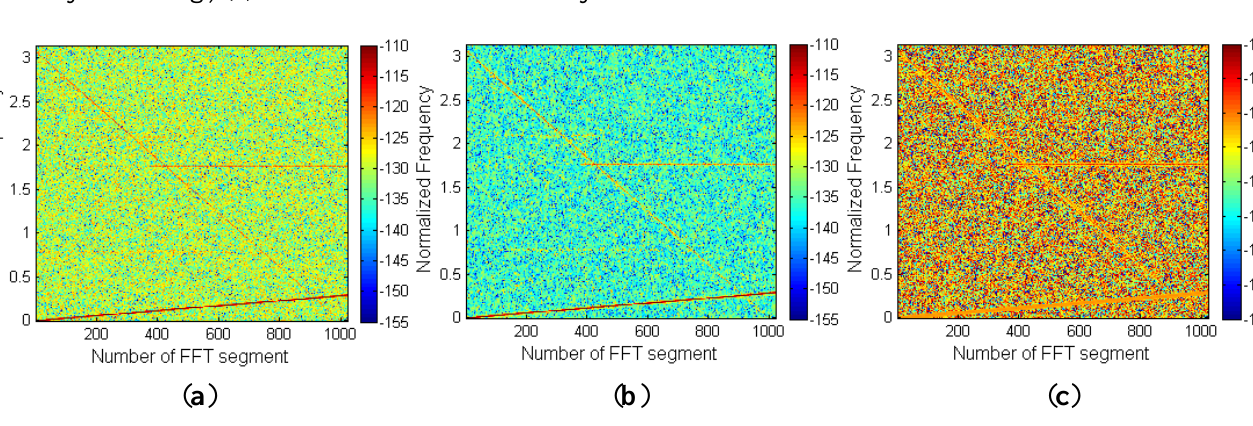
Figure 16. Locally adaptive linear minimum mean square error (LLMMSE) Algorithm applied to an RFI contaminated radiometric signal. ( a ) RFI contaminated signal’s spectrogram, σ 2 = σ 2 − 5 dB; (b) Estimation of the RFI present in the radiometric signal RFI n by denoising; ( c ) Cleared radiometric data by RFI